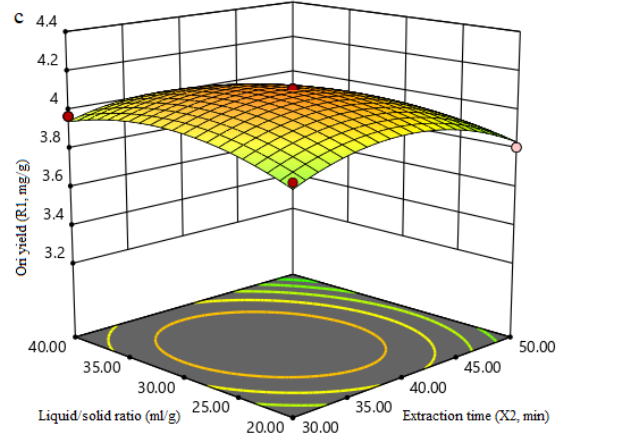
Figure 2. 3D response surface plots of independent variables in extraction yield of Ori: ( a ) Effects of ethanol